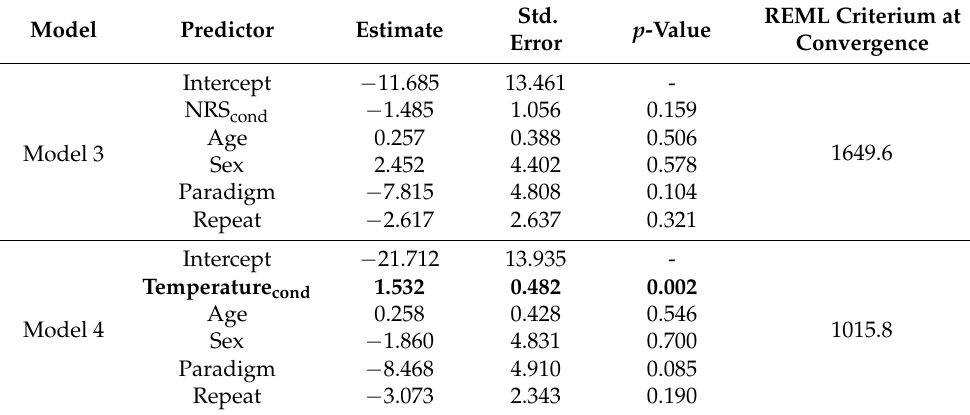
Table 3. Relation between CPM effect and CS pain intensity or physical intensity (temperature) in the repeated measures analysis. Linear mixed effect analysis of Model 3 (n = 85 participants, 184 observations) and Model 4 (n = 52 participants, 118 observations), see Methods for model specification. p -values were obtained by Wald’s Chi-Square test on the fitted mixed models. NRScond, CS pain intensity rating on the NRS [0–10]. Temperaturecond, temperature of the CS (cold water bath). Paradigm, 30 s heat/60 s cold as opposed to Electrical/cold120s (reference). Repeat refers to the measurement repeat and is used to control for order of measurement. Significant effects are marked in